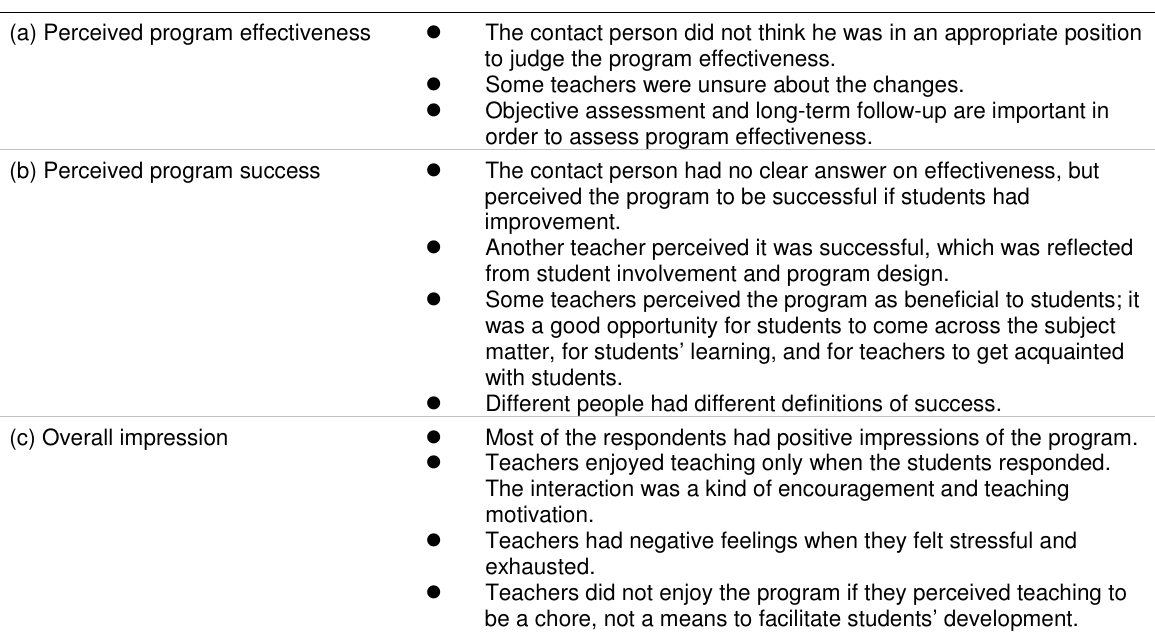
Consolidated Interpretations on the Perceived Program Effectiveness, Program Success, and Overall Impression Integrated Findings and